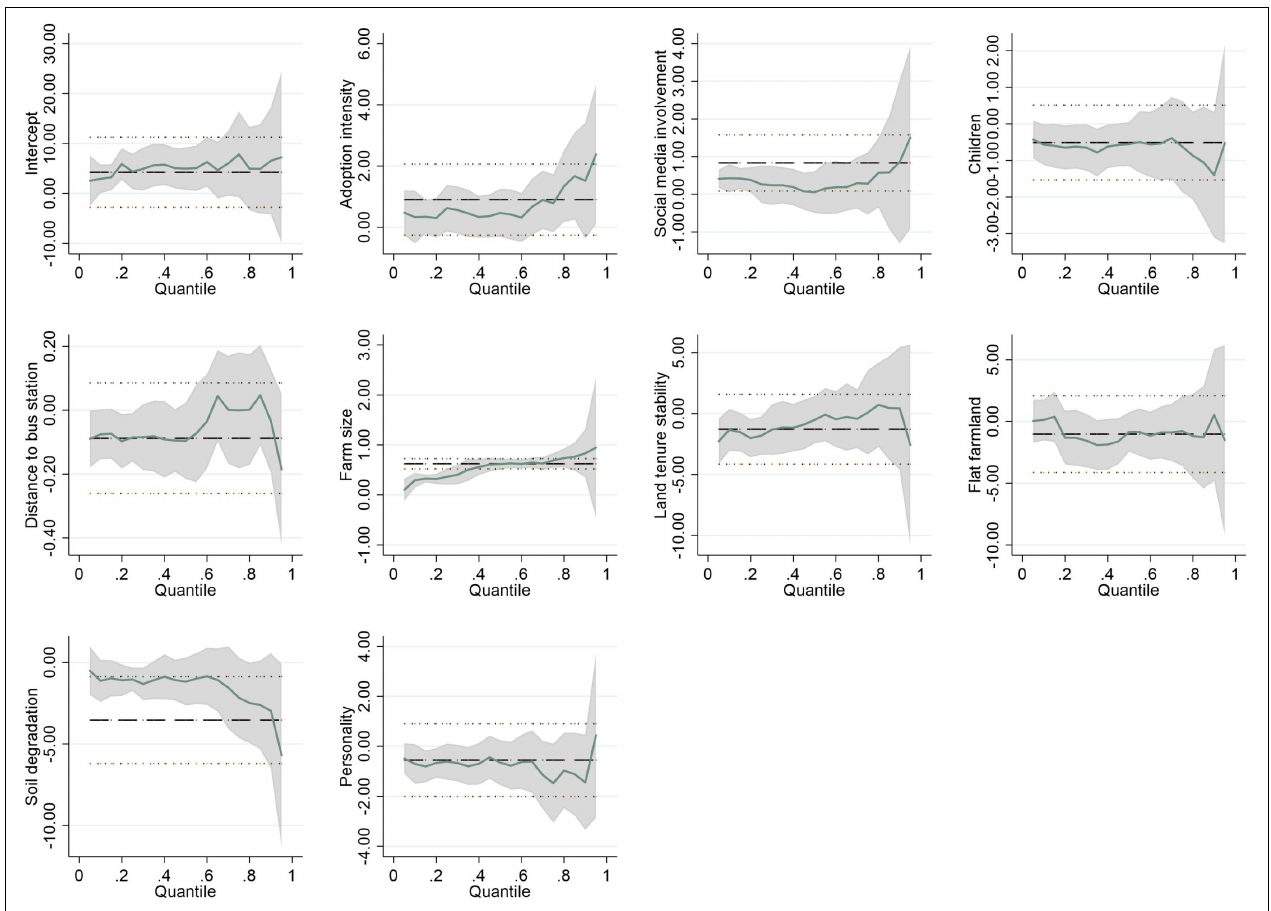
FIGURE 3 | Quantile estimates: The impacts of factors on household income. Shaded areas represent 95% confidence band for the quantile regression estimates. The black dotted lines denote the conventional 95% confidence intervals for the